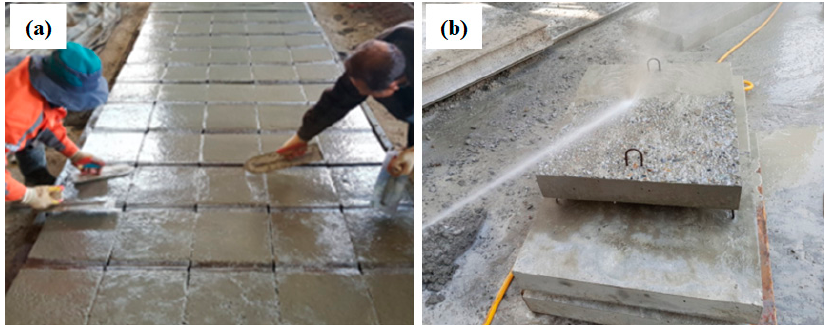
Figure 3. Concrete specimen casting and surface preparation procedure: ( a ) concrete substrate fabrication, and ( b ) water jetting to make a rough surface.